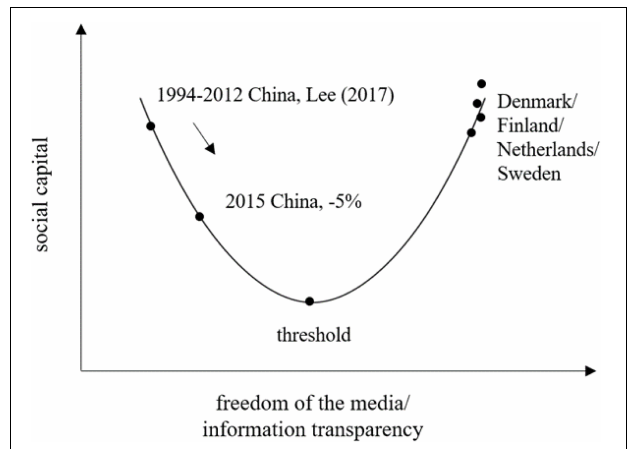
FIGURE 2 | The U-relationship between media freedom and social capital. The graph is computed based on authors’ calculation and Lee (2017).